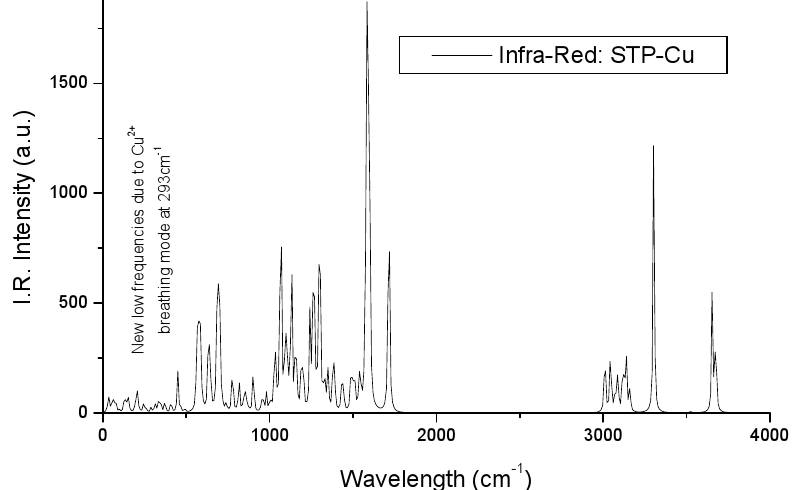
Figure 9. Calculated infrared spectrum of staphylopine chelated to divalent copper. Main lines remain similar to the metallophore infrared spectrum (Figure 3); however, new modes occur due to the presence of the copper ion, such as the “breathing mode” at ~293 cm − 1 .